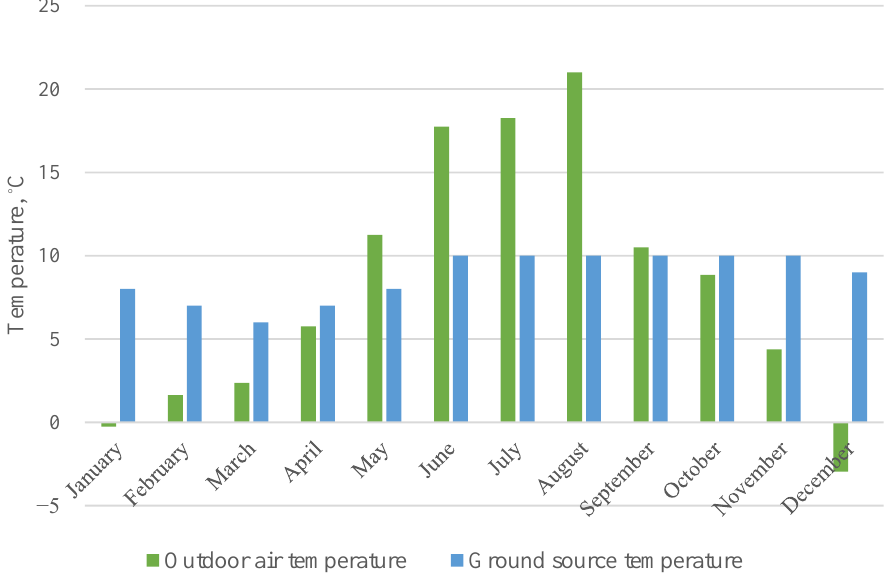
Figure 5. Average monthly temperatures of the primary heat sources.